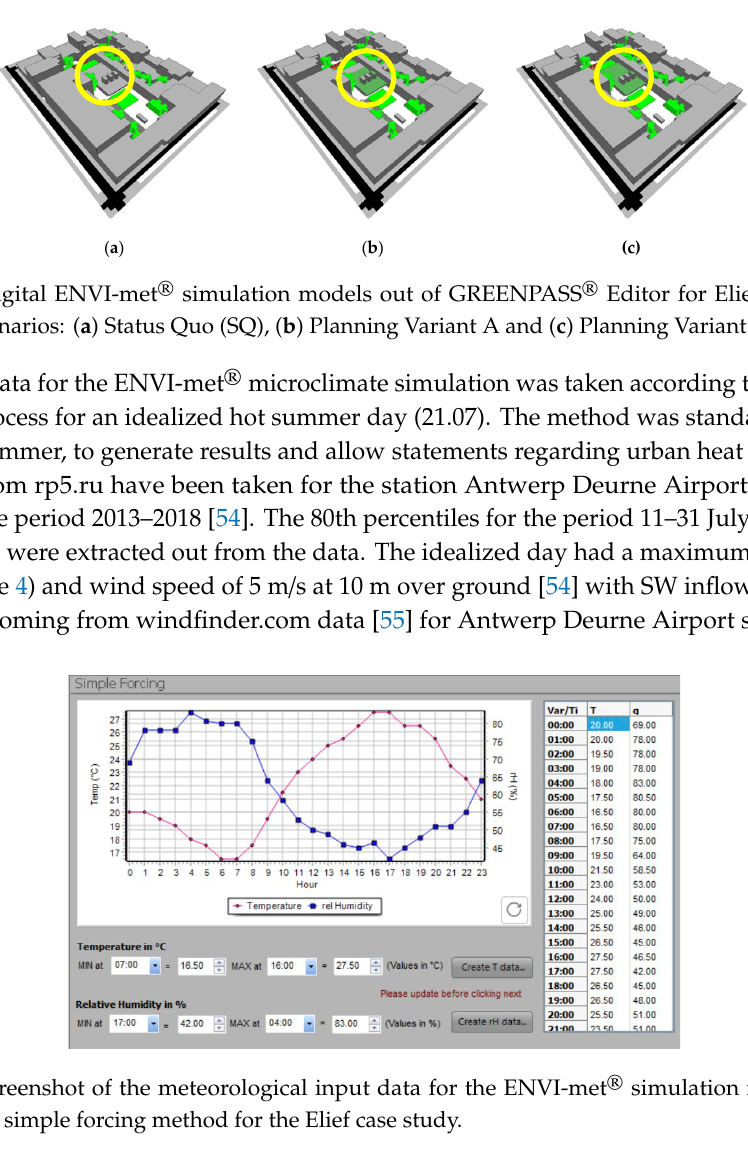
Figure 4. Screenshot of the meteorological input data for the ENVI-met ® simulation in an hourly profile using simple forcing method for the Elief case